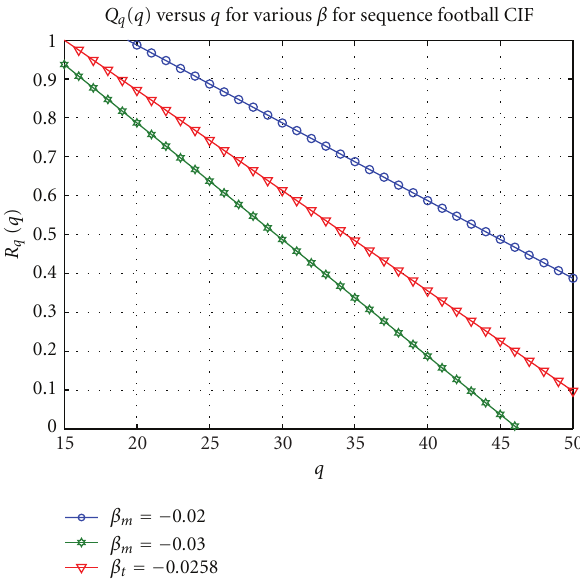
Figure 13: Rate versus quantization parameter at various d for sequence football CIF: d t = true value, d m = misreprted value. Table 4: Quantization parameter and bitrate for sequence football,